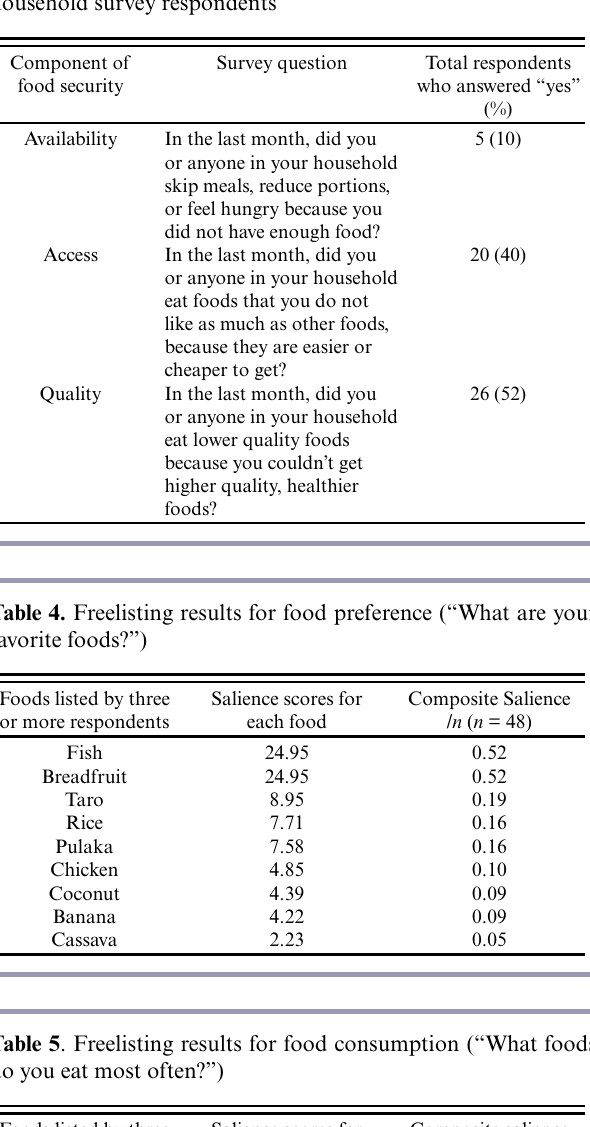
Table 3. Experiences of food security in the past month among household survey respondents